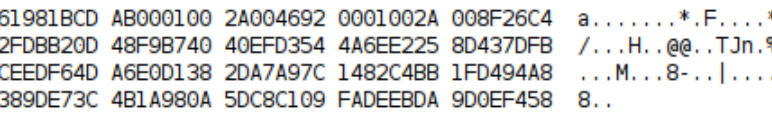
Figure 2. Sample